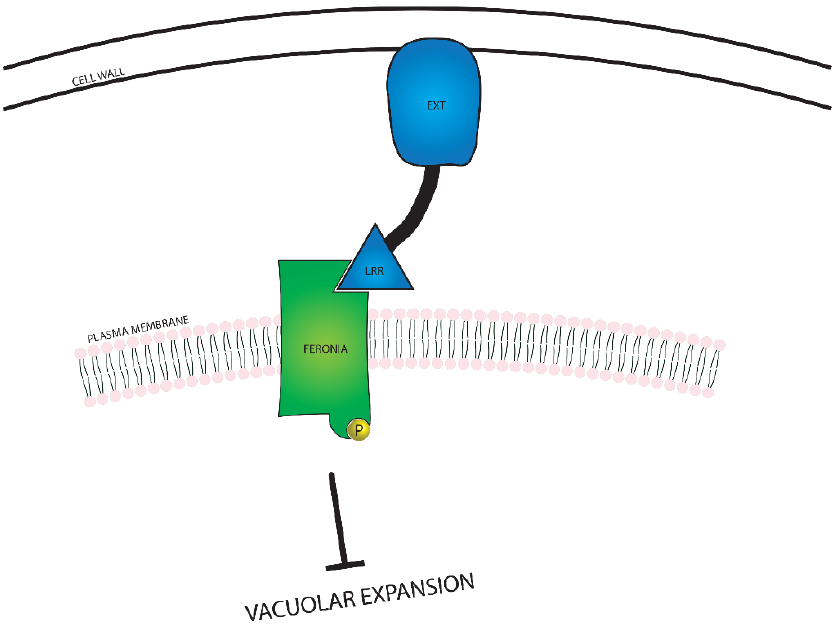
Figure 5. A visual representation of the relationship between FERONIA and Leucine-Rich Repeat Extensin (LRX) proteins. FERONIA resides in the plasma membrane, while the LRX protein exists in the space between the cell wall and the plasma membrane. In the event that the cell wall is close enough to the plasma membrane for the LRX protein to bind to both the cell wall and FERONIA, vacuolar expansion is inhibited.